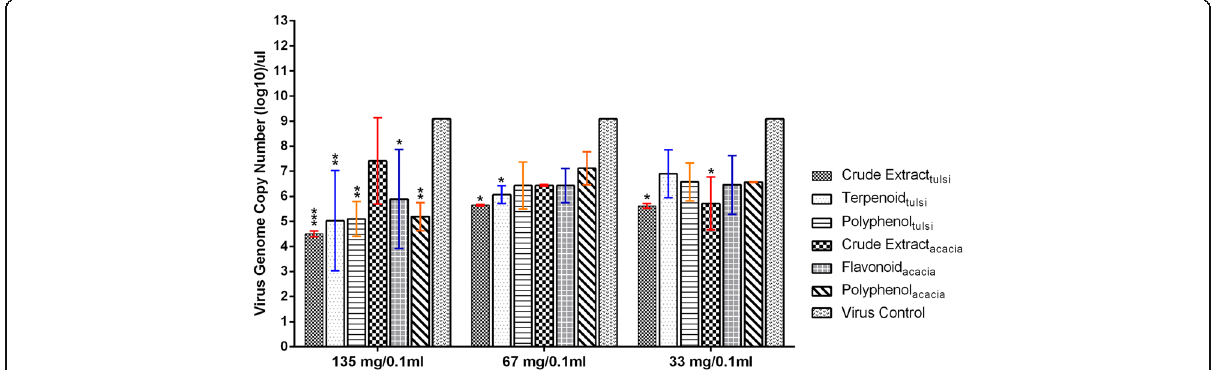
Fig. 3 Assessment of virucidal activity of the O. sanctum and A. arabica leaves extracts in a dose-dependent manner by Real Time RT-qPCR assay.